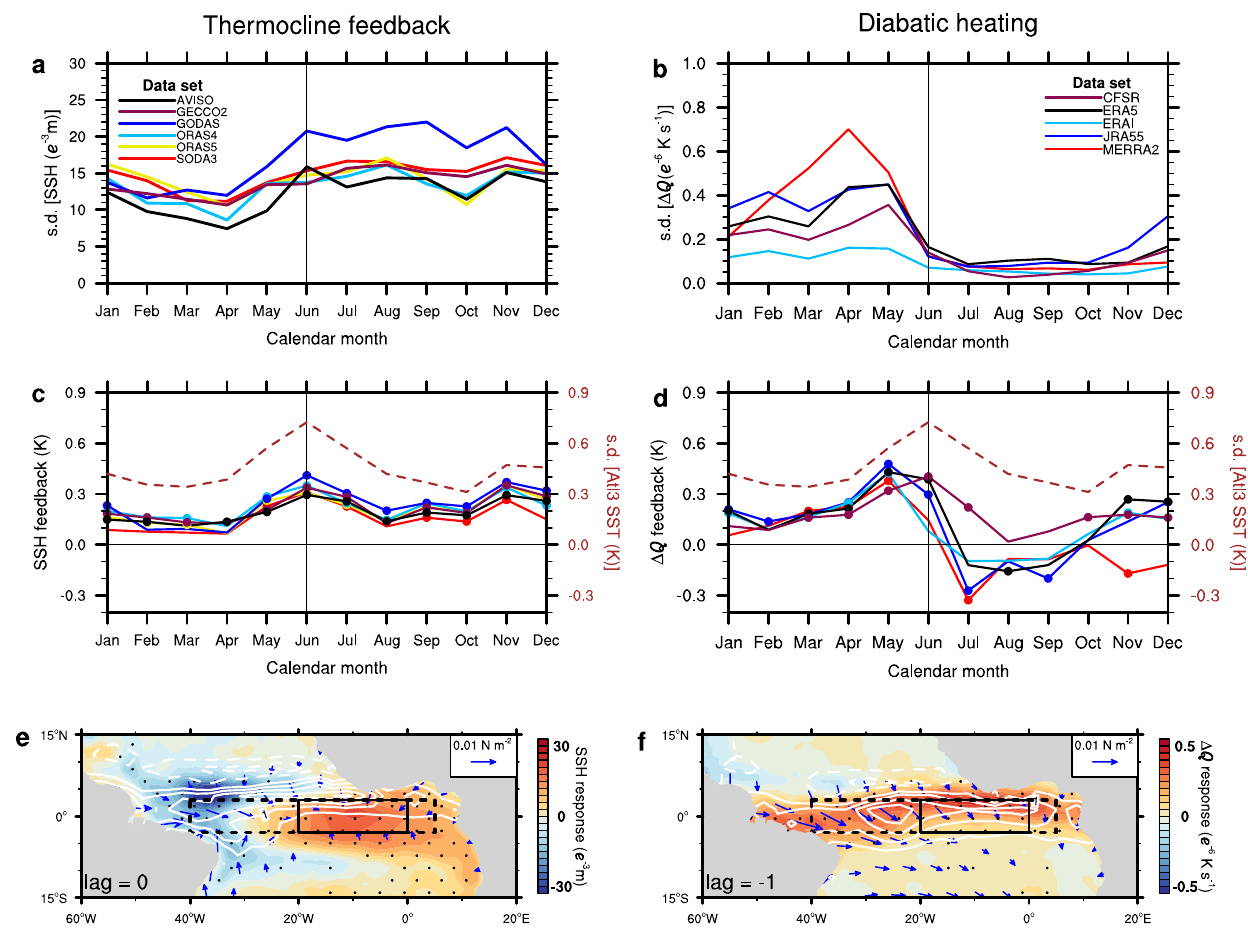
Fig. 1 Seasonality of thermocline feedback and diabatic heating. Standard deviations of seasonally strati fi ed a sea surface height (SSH) and b diabatic heating gradient ( Δ Q ) averaged over the equatorial Atlantic region (3°N – 3°S, 5°E – 40°W; shown by dashed boxes in Fig. 1 e and f ) in multiple data sets. c (left scale) Thermocline feedback ( K ) calculated as Atl3 SST (that is, average in the region 3°N – 3°S, 0° – 20°W shown by the solid boxes in Fig. 1 e and f ) regressed on the normalized basin SSH index for each calendar month. d (left scale) Atl3 SST regressed on the normalized basin Δ Q index for each calendar month. In c and d , the right scale shows the seasonally strati fi ed standard deviations of the Atl3 SST ( K ). Symbols on the lines denote statistical signi fi cance at the 95% con fi dence level. e The in-phase anomalies of SSH (color scale), wind stress (only statistically signi fi cant vectors are plotted) and precipitation (white contours, at interval of 0.5 mm day − 1 ) regressed on the normalized Atl3 SST in June. f The anomalies of Δ Q (color scale), wind stress (only statistically signi fi cant vectors are plotted) and precipitation (white contours, at interval of 0.5 mm day − 1 ) in May regressed on the normalized Atl3 SST index in June. In e and f , the SSH, Δ Q and wind stress are based on the ensemble-means of the different data products (see Methods); stippling denotes statistical signi fi cance at the 95% con fi dence